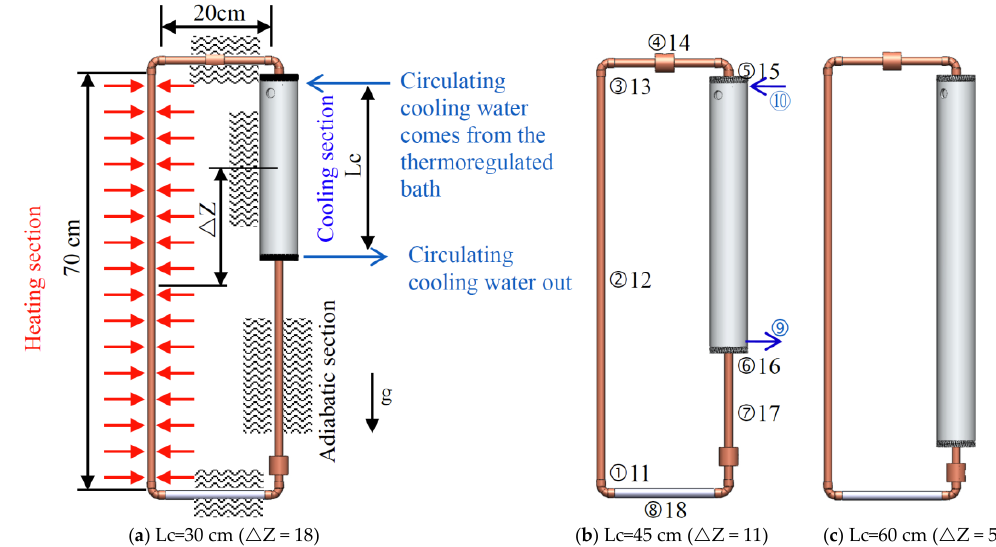
Figure 2. Experimental test cell and geometric parameters.